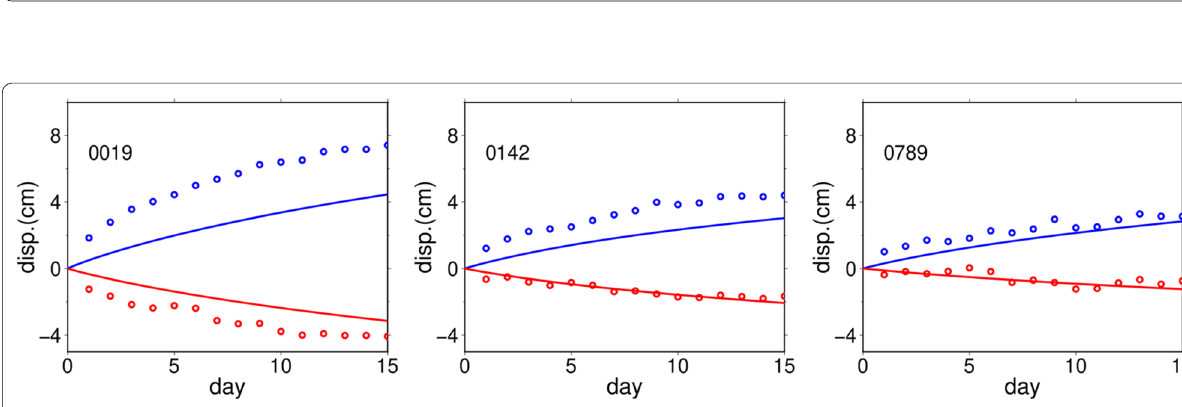
Kano et al. (2015) estimated the spatial distribution of the frictional parameters in the afterslip region following the 2003 Tokachi-oki earthquake using an adjoint data assimilation method. The only difference between this study and Kano et al. (2015) is the assimilated observa- tion data: Kano et al. (2015) adopted the slip velocity on